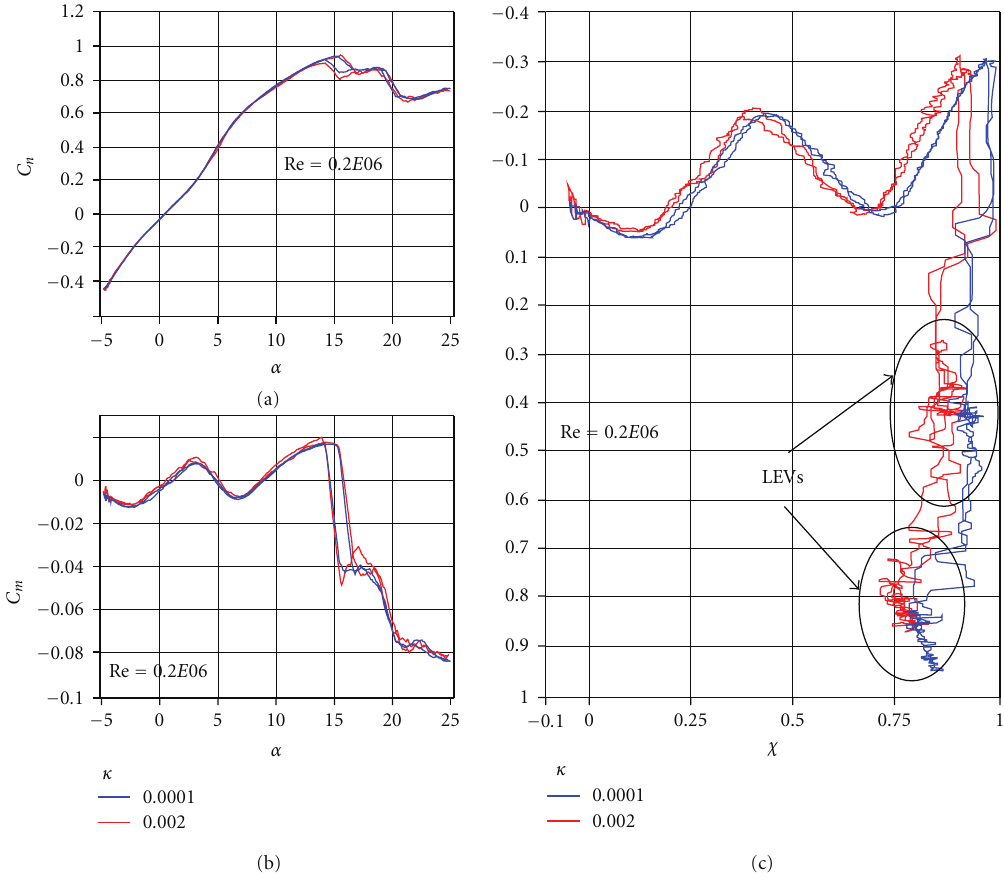
Figure 13: (a) C n versus α , (b) C m versus α , (c) x − γ plot; for κ = 0 . 0001 and 0.002 at constant Re = 0 . 2 E